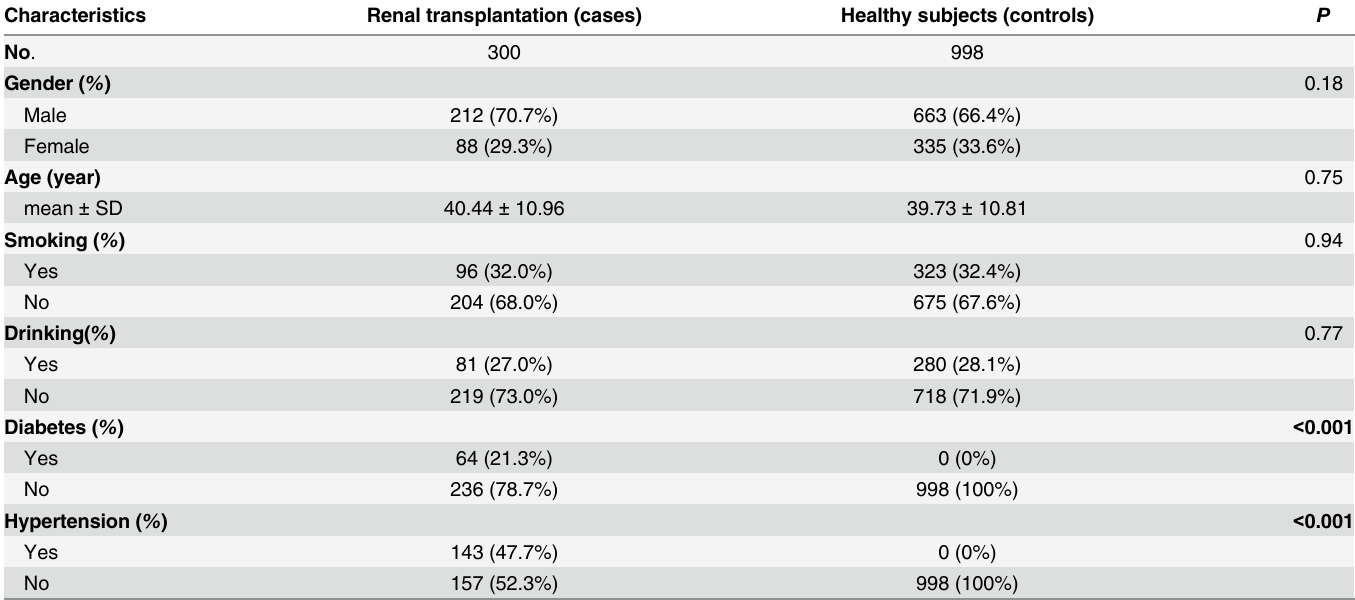
Table 2. The demographic characteristics of cases and